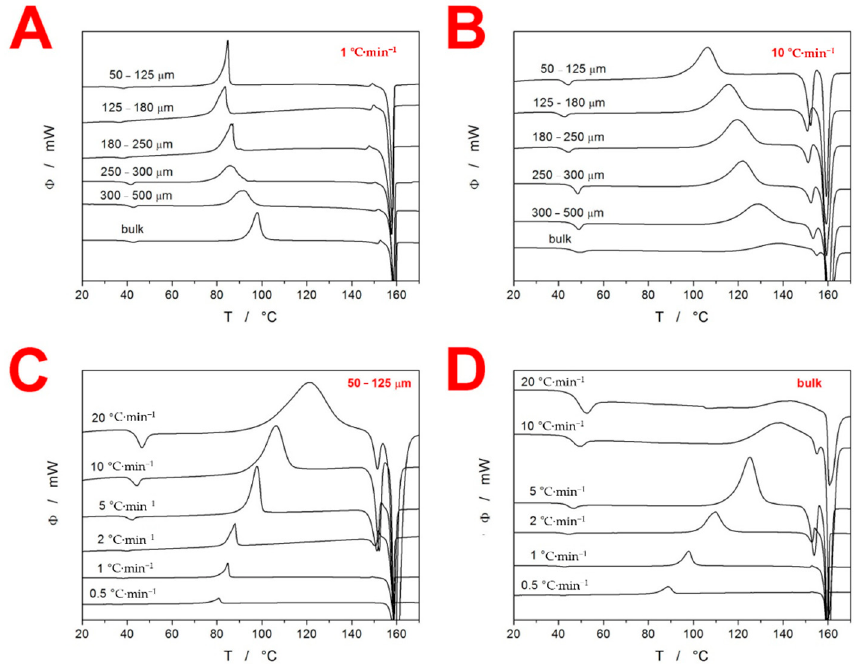
Figure 1. Example DSC curves obtained for the various fractions of IMC powders measured at selected heating rates q + . Exothermic effects evolve in the upwards direction: ( A ) all particle size fractions measured at 1 ◦ C · min − 1 ; ( B ) all particle size fractions measured at 10 ◦ C · min − 1 ; ( C ) 50–125 µ m-particle size fraction measured at all q + ; ( D ) bulk µ m-particle size fraction measured at all q + .